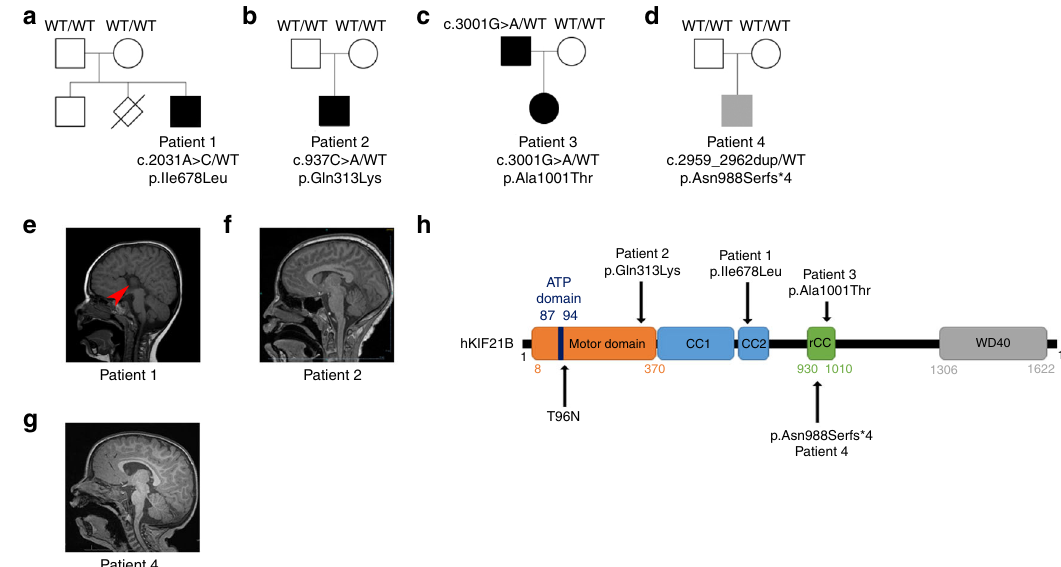
Fig. 1 Patients with KIF21B variants. a – d Pedigrees of patients with identi fi ed KIF21B variants. e – g Sagittal brain section of patient ’ s MRI showing a complete agenesis of the corpus callosum in patient 1 ( e , red arrow) and microcephaly in patient 2 ( f ). h Schematic representation of the human KIF21B (hKIF21B) protein indicating the different domains (motor domain, ATP binding site, coiled-coil domain (CC) 1 and 2, regulatory coiled-coil domain (rCC) and WD40 domain) and the position of the mutated amino acids for patient 1 (p.Ile678Leu), 2 (p.Gln313Lys), 3 (p.Ala1001Thr) and 4 (p.Asn988SerfsX4). T96N substitution that abolishes KIF21B mobility is also (Fig. 2c and Supplementary Fig. 2b, c). mKif21b staining speci fi city